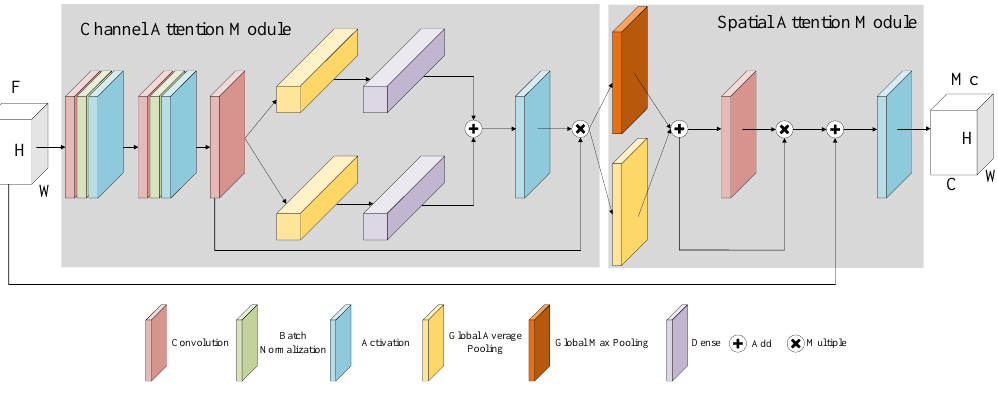
Figure 7. Residual attention module.